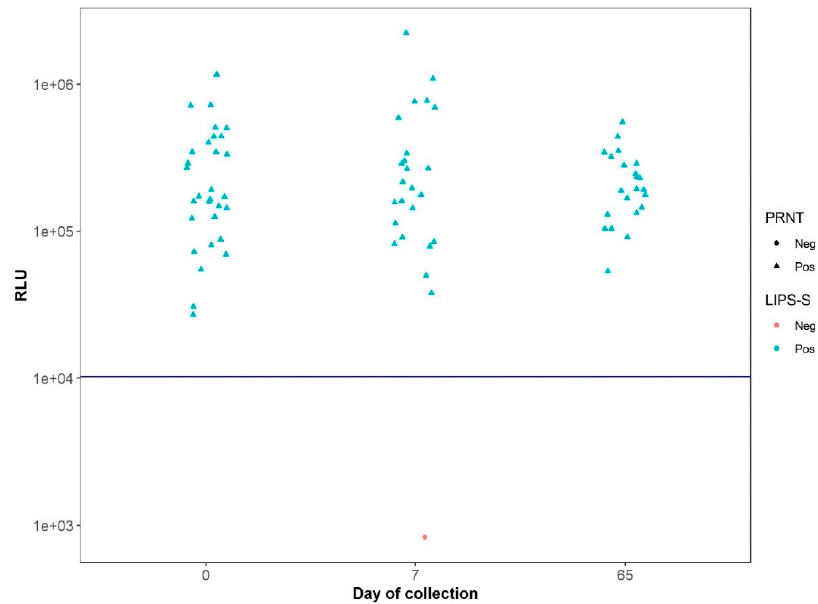
Figure 4. Distribution of RLU values determined by LIPS-S assay using sera from naturally-infected mink samples across the lower threshold line (blue) and according to the serum collection date. Note that, independent of the serum collection times, the LIPS-S assay correctly identified all samples according to their positive and negative status as determine by antibody neutralization activity.